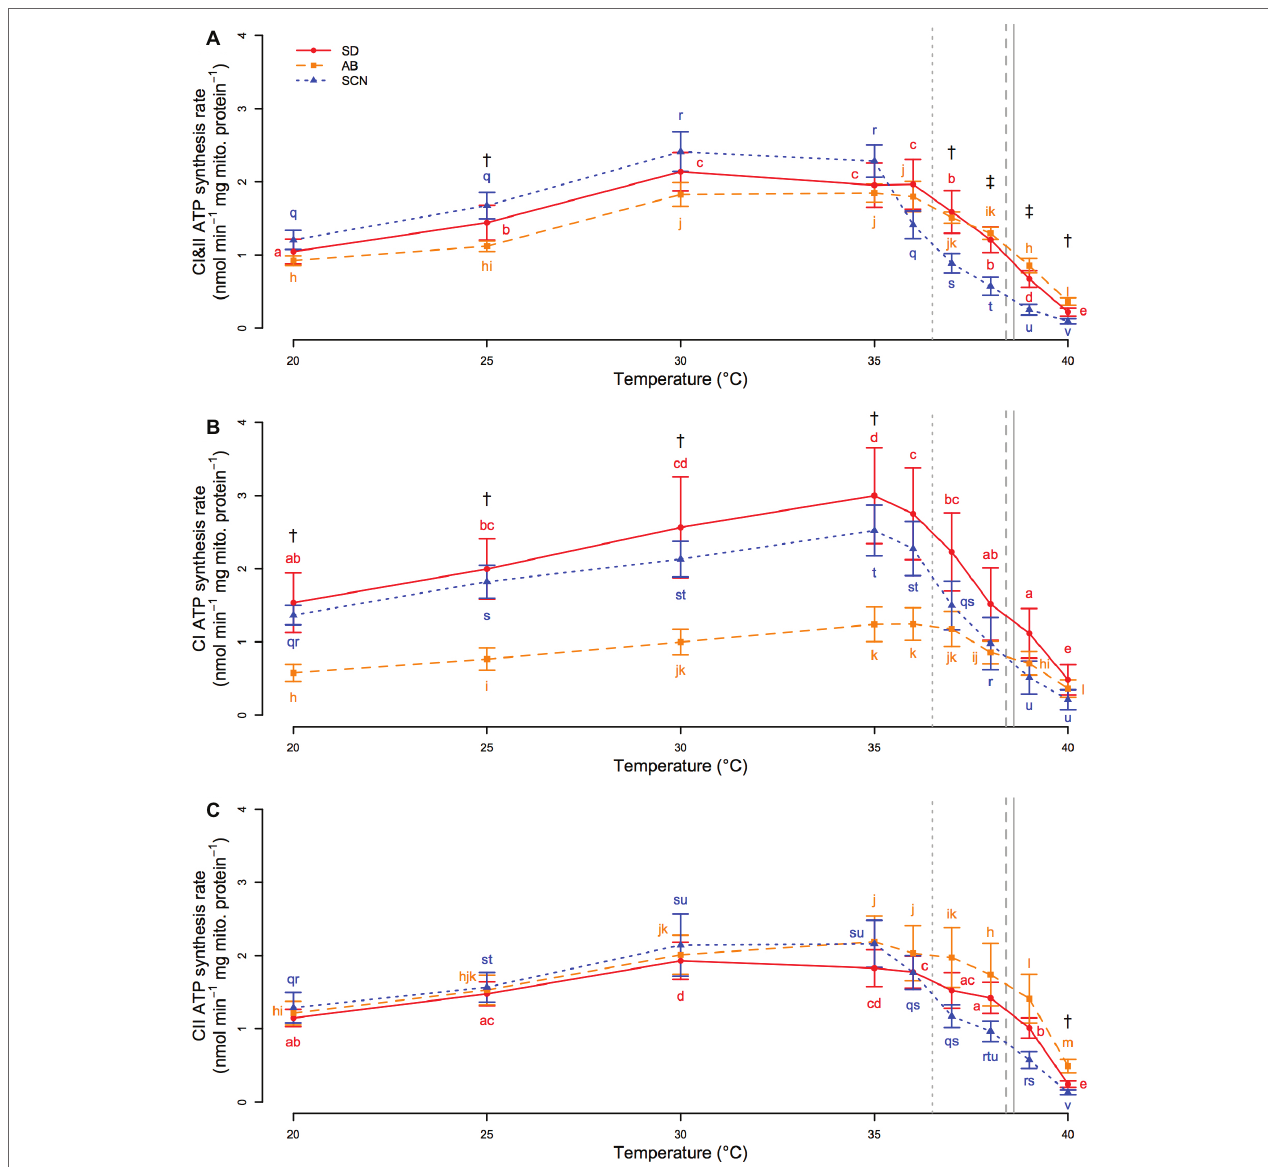
FIGURE 4 | CI&II- (A) , CI- (B) , and CII-fueled (C) ATP synthesis rate from 20 to 40 ° C in San Diego (SD; red, circles, solid lines), Abalone Cove (AB; orange, squares, dashed lines), and Santa Cruz (SCN; blue, triangles, dotted lines) copepods. Data are presented as mean ± SEM. Letters indicate the results of post-hoc tests within populations. Daggers indicate temperatures at which there is a difference between SCN and AB. Double daggers indicate temperatures at which there is a difference between SCN and both AB and SD. Vertical gray lines display mean knockdown temperatures for each population (SD – solid; AB – dashed; SCN –